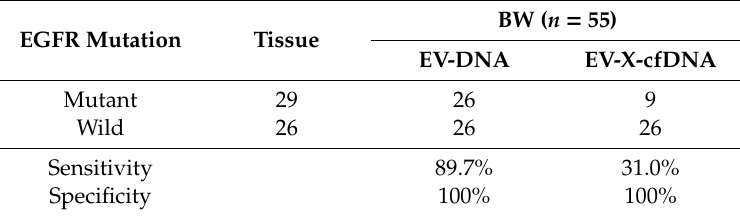
Table 2. Detection rate of EGFR mutation by real time PCR using bronchial washing sample; EV-DNA and EV-excluded-cell free DNA (EV-X-cfDNA) from bronchial washing